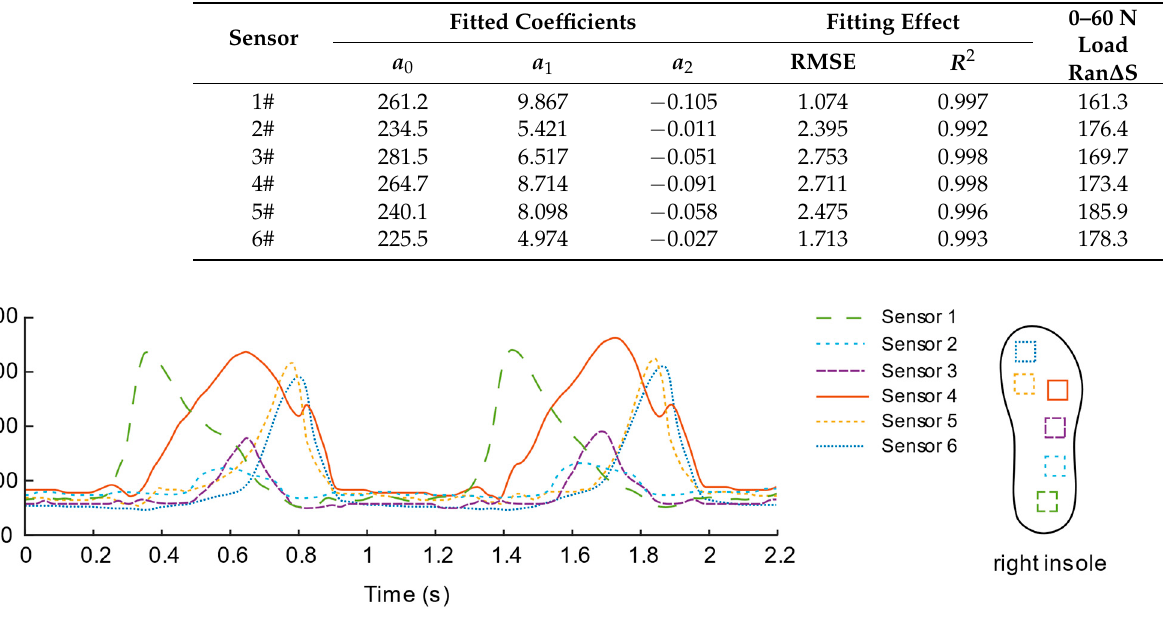
Figure 10. Signal Curve of the first insole solution.